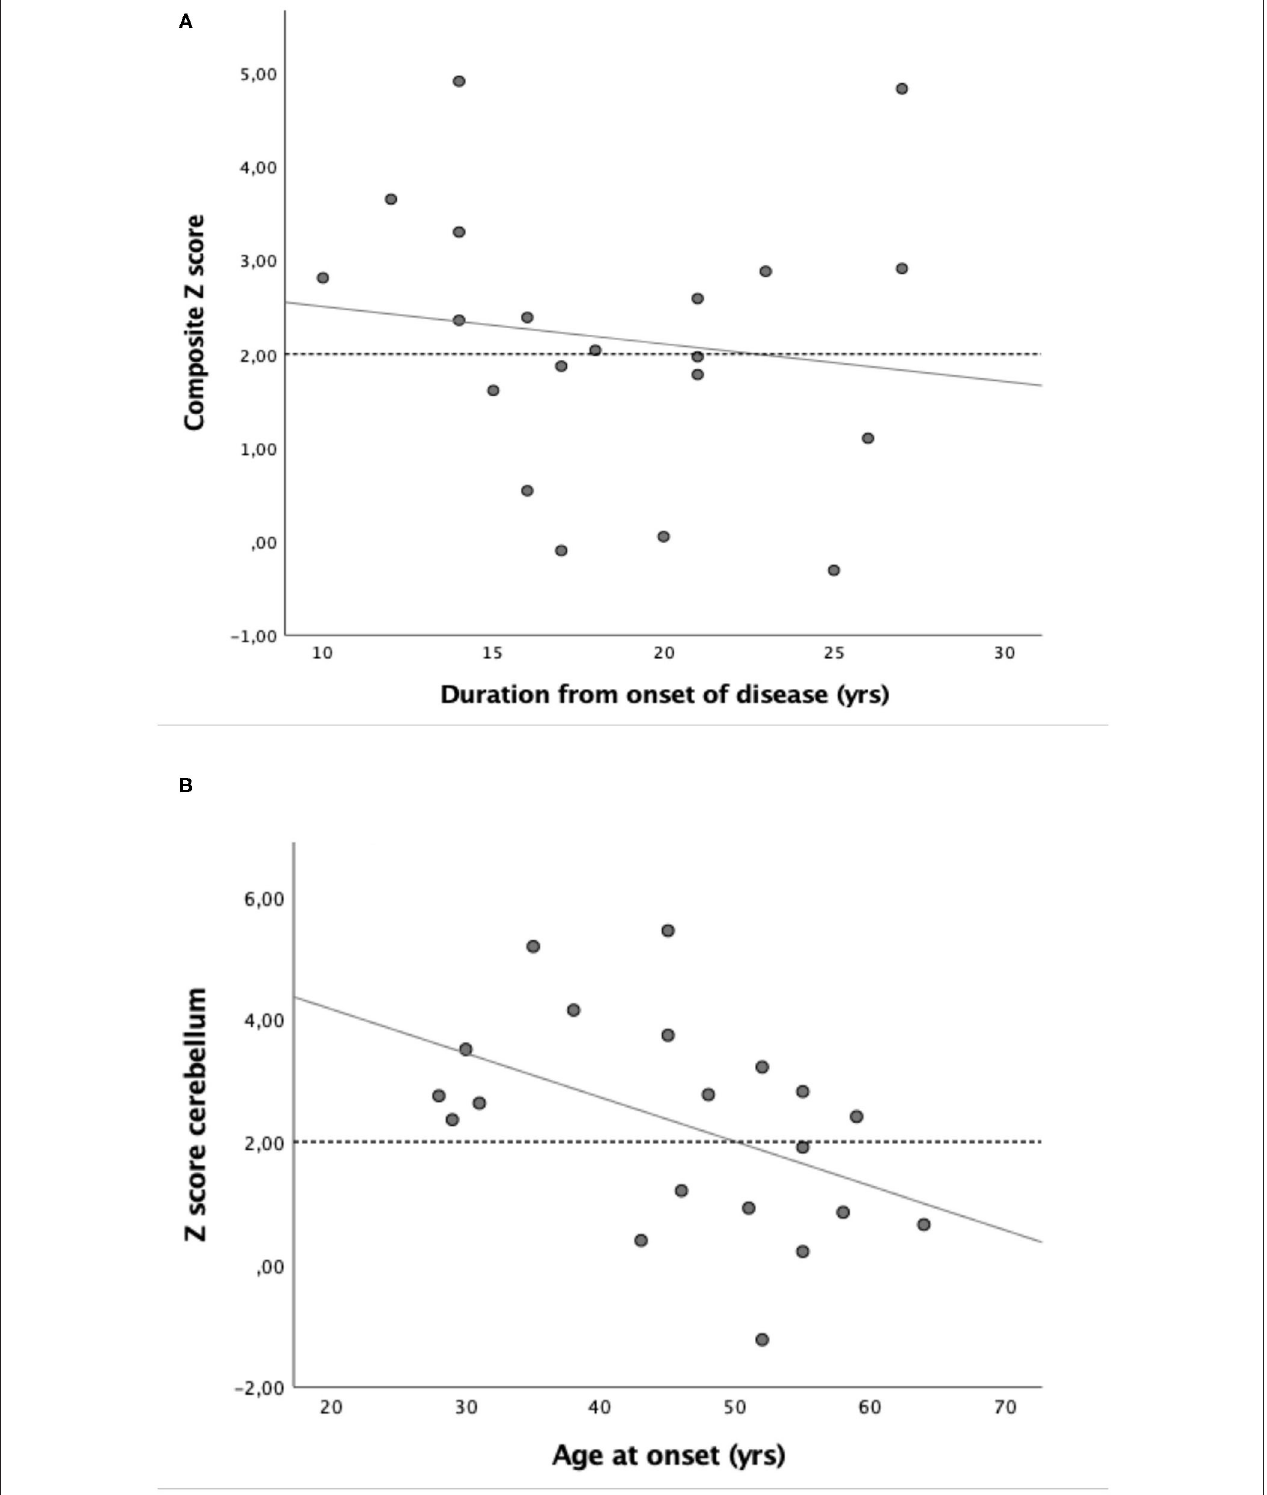
FIGURE 2 | Scatter plot of the relationship between (A) composite Z-score and duration of disease from diagnosis ( r S = − 0.20; NS) and (B) relationship between Z-score cerebellum and age at onset ( r S = − 0.45; P < 0.05).